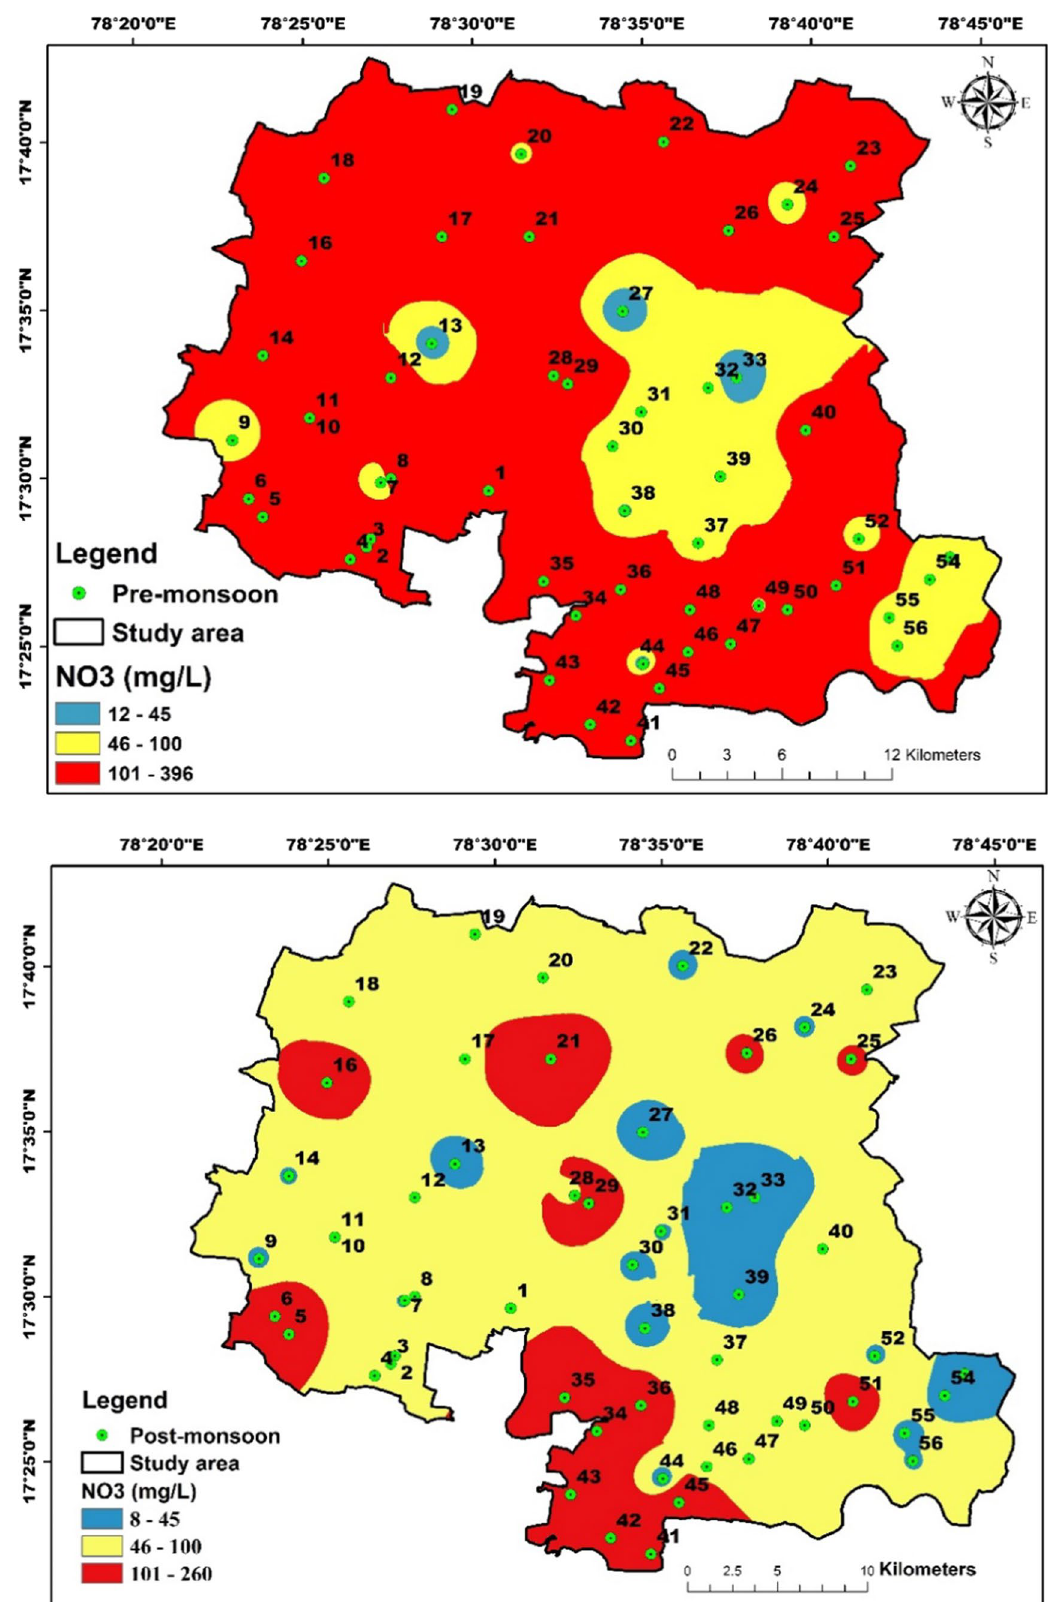
Fig. 5 Spatial distributions of NO 3− concentration in the pre and post-monsoon